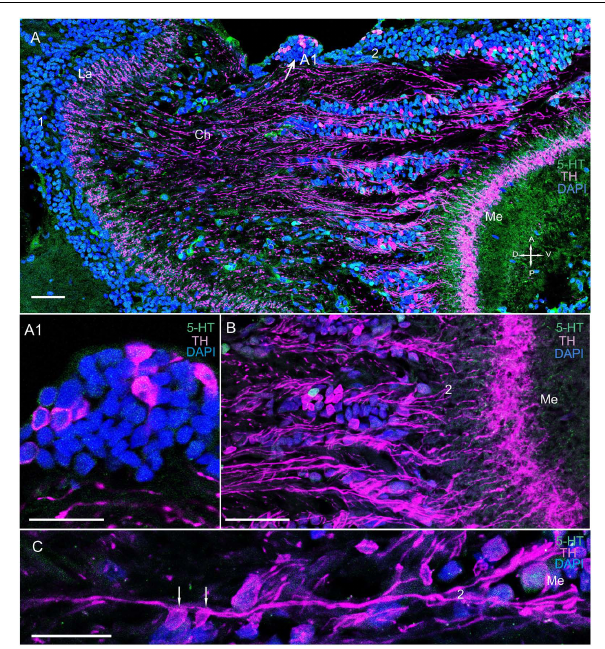
FIGURE 4 | Immunolocalization of TH and 5-HT in the medulla. (A) TH- and 5-HT-positive bodies of neurons connecting the La to the Me. (A1) Localization of TH in neurons at the first Ch and closer to the Me (arrows). (B) Immunolocalization of TH and 5-HT in neurons and nerve fibers of the Me. (C) TH localization in neurons and varicose fibers connecting the La and the Me. Green, 5-HT; magenta, TH; blue, DAPI. Scale bars = (A,B) 100 µ m and (A1,C) 50 µ m. La, lamina; Me, medulla; 1, 2, cell clusters; Ch, optic chiasma; D, dorsal; V, ventral; A, anterior; P,